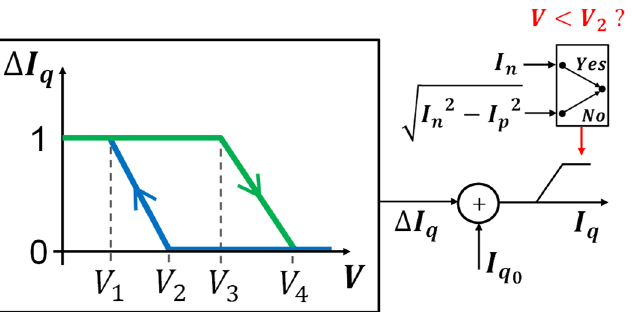
Figure 15. Proposed reactive current/voltage strategy for converter-based generators operating as grid-following units.